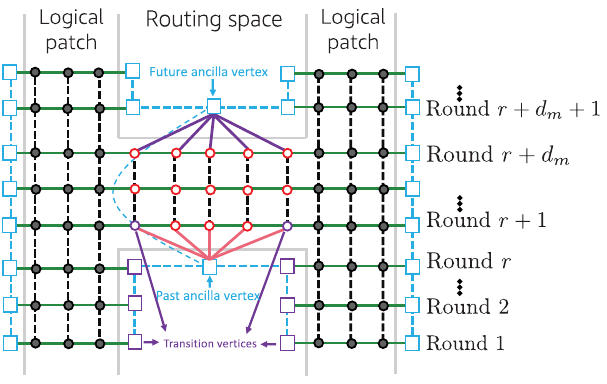
FIG. 6. A 2D slice of the surface-code matching graph in the timelike direction for syndrome-measurement rounds performed during an X ⊗ X measurement protocol using lattice surgery. The vertical axis corresponds to the timelike direction. We show a subset of the vertices and edges of the matching graph for cor- recting Z errors for an X ⊗ X measurement using lattice surgery. The parity vertices are the white and red vertices in the ancilla patch region. The transition vertices are both boundary and parity vertices colored in purple. The pink edges are past vertical edges incident to the past ancilla vertex and the parity vertices in round r + 1, whereas the purple edges are future ancilla edges incident to the parity vertices in round r + d m and the future ancilla ver- tex. We also add a dashed-blue weightless edge connecting the past and future ancilla vertices.